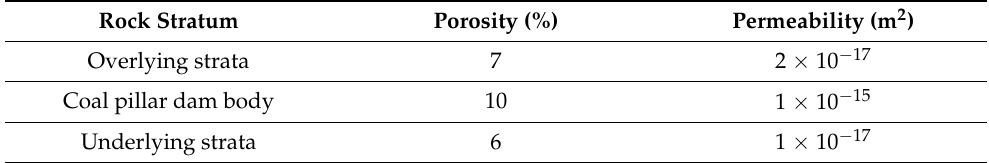
Table 1. Porosity and permeability parameters of rock formation. Rock Stratum Porosity (%) Permeability (m 2 ) Overlying strata 7 2 × 10 − 17 Coal pillar dam body 10 1 × 10 − 15 Underlying strata 6 1 × 10 −